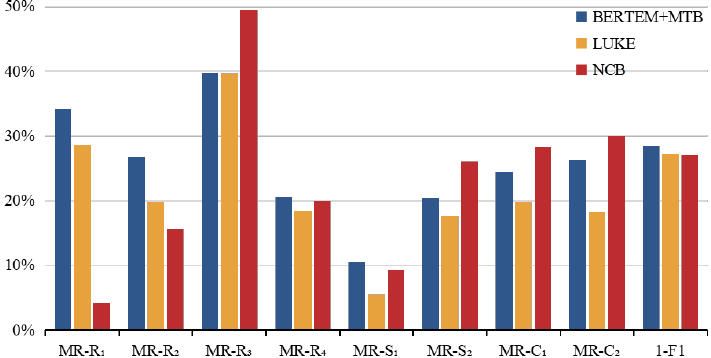
Figure 3. Comparison of F1 scores and violation rates on different MRs for three RE